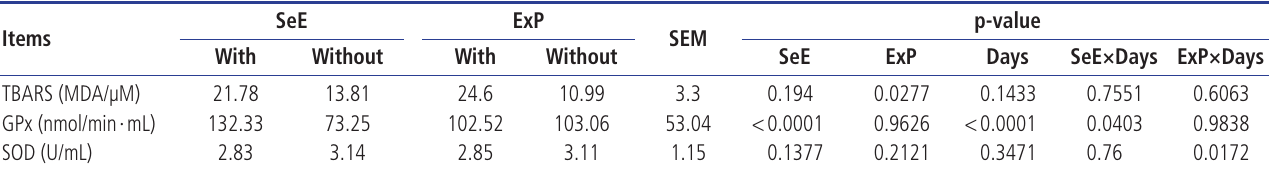
Papilla number/cm 2 of wall